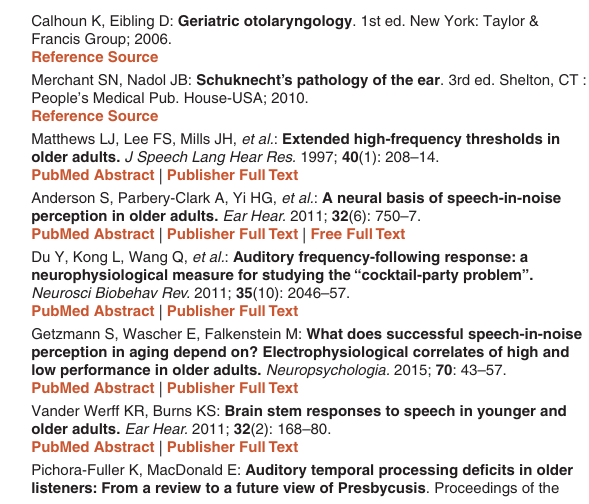
Table 1 (Details and steps of the rehabilitation program). Table 2 (Schedule of temporal processing-based program). Table 3 (The data collection sheet of the study).docx • Table 4 (Participant